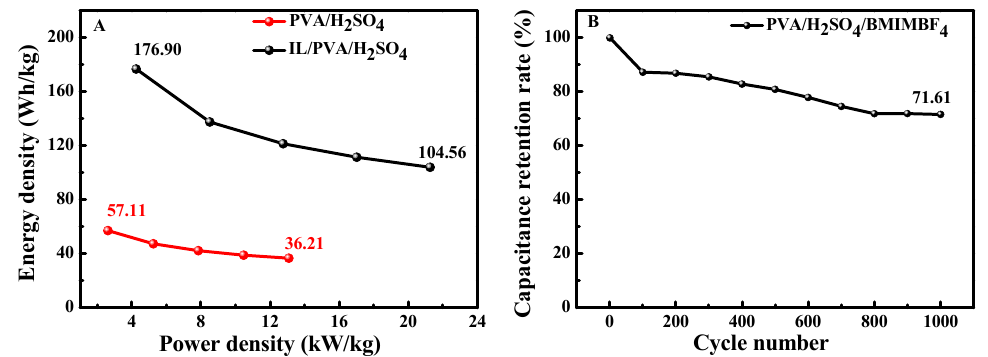
Figure 5. Ragone plot of the SSC based on two GPEs ( A ) and the capacitance retention rate of